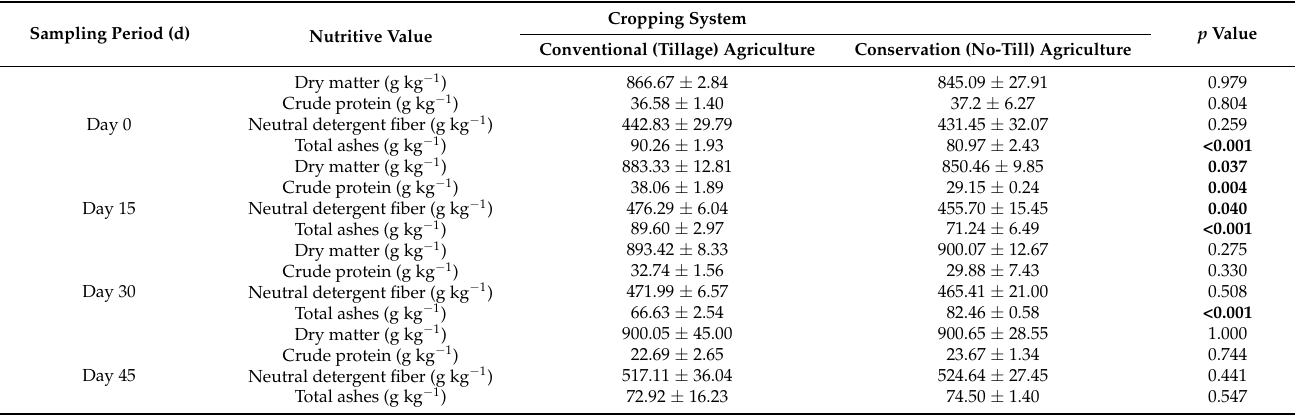
DM, CP, and NDF tended to be lower in Conser-A- than Conven-A-grown stubble, with a significant effect on Day 15. For example, DM was 883.36 g kg − 1 in Conven-A and 850.46 g kg − 1 in Conser-A on Day 15 (Table 3). With time, DM and NDF tended to increase for both cropping systems, while the opposite trend was observed for CP. Both the sampling time and cropping system significantly affected the AC (Table 2). AC was lower in Conser-A- than Conven-A-grown stubble on Days 0 and 15. On Day 30, the opposite was found, with no difference on Day 45 (Table 3). Table 3. Nutritive value of the stubble of wheat grown under conventional tillage and no-tillage cropping